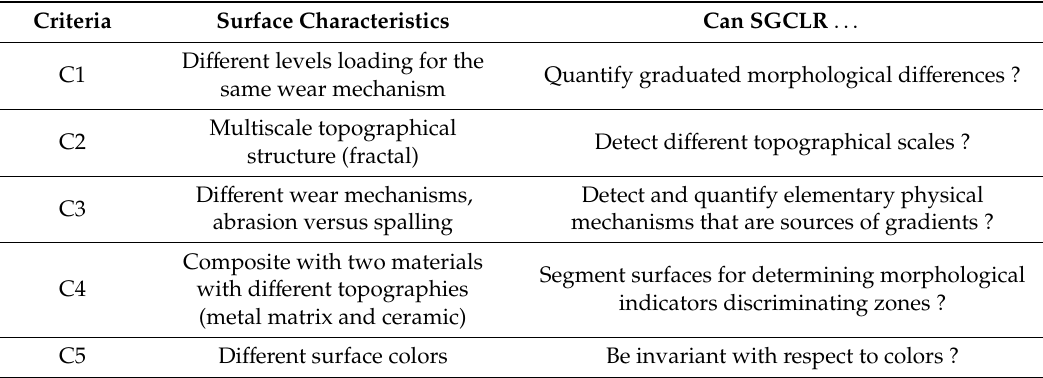
Table 1. Specifications for testing SGCLR.